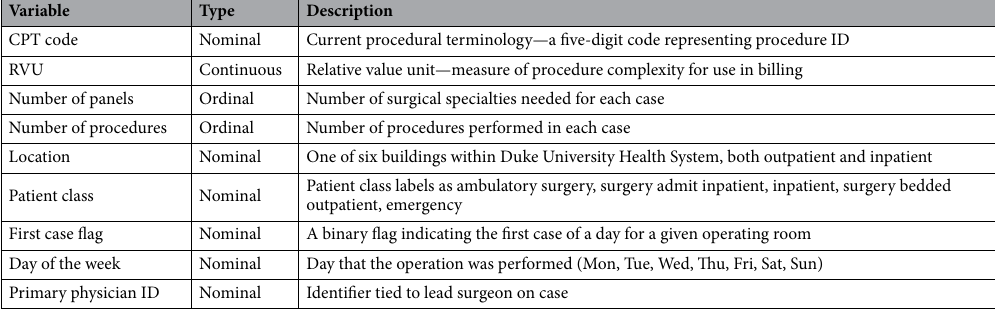
Table 1. Feature descriptions.